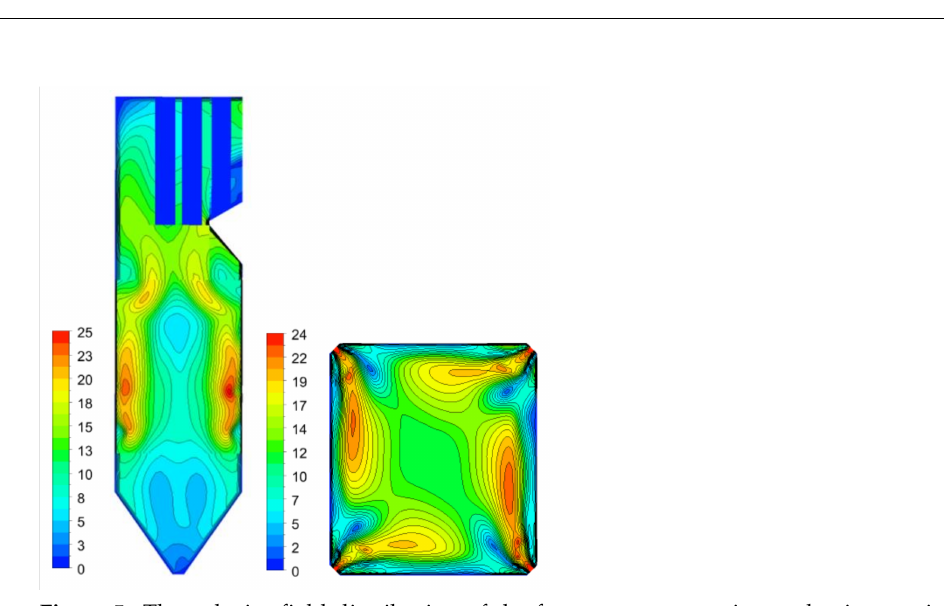
Figure 5. The velocity field distribution of the furnace center section and primary air section (velocity: m · s − 1 ).